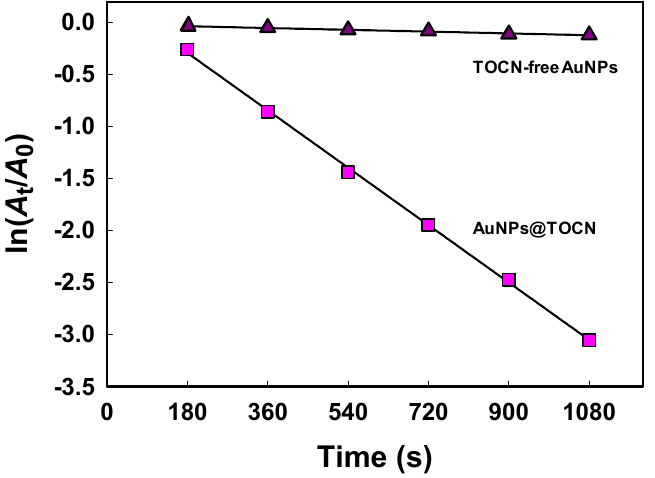
Figure 7. ln( A / A ) versus reaction time for the catalytic reduction of 4-NP; AuNPs @ TOCN t 0 (squares) and TOCN-free AuNPs (triangles).